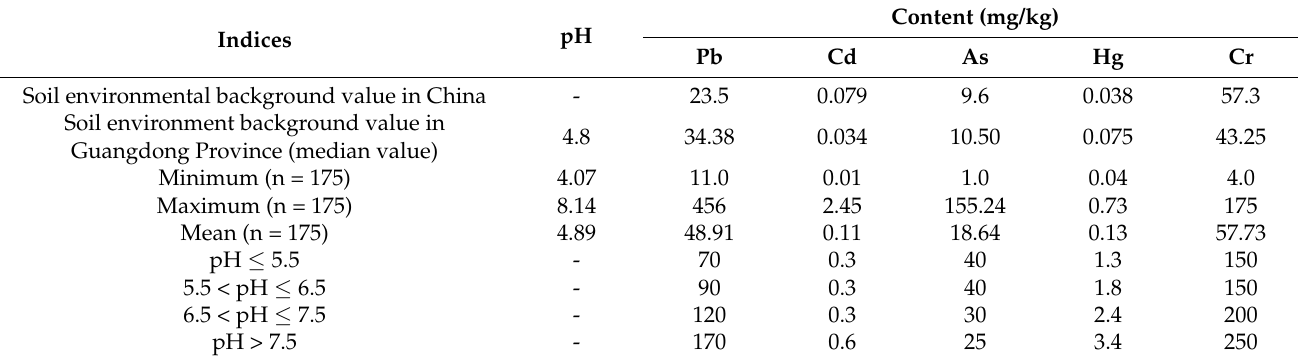
Table 1. The limit standard for heavy metals in